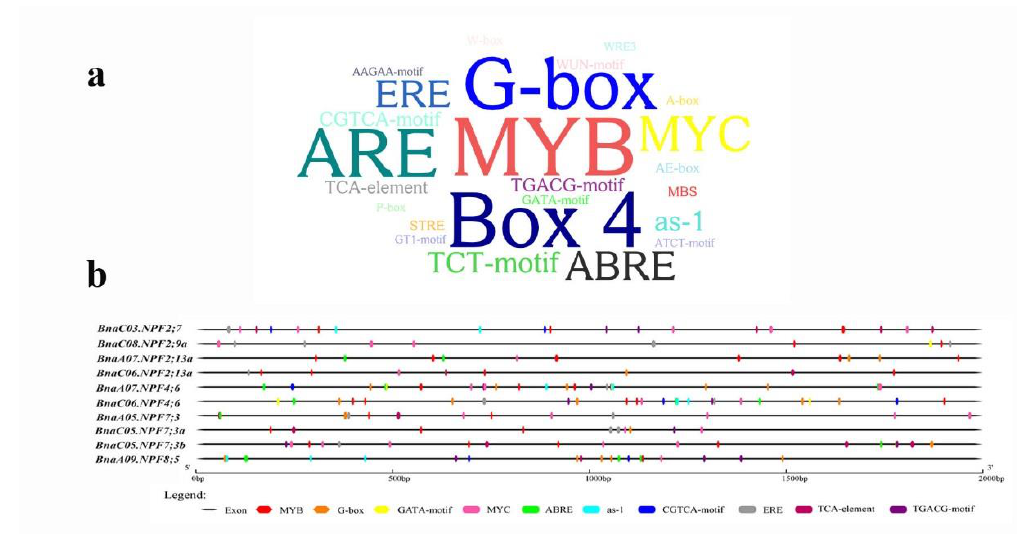
Figure 10. Identification of the cis -regulatory elements (CREs) in the 2.0-kb promoter region of the 10 core BnaNPF genes. ( a ) Over-presentation of the CREs in the promoters of the 10 core BnaNPF genes. The more the CREs, the bigger the typeface size. ( b ) Nitrogen responsive CREs (double sided wedge) and phytohormone responsive CREs (round-corner rectangle) were showed in the promoter regions of the 10 core BnaNPF genes. Different CREs are indicated with different colors.